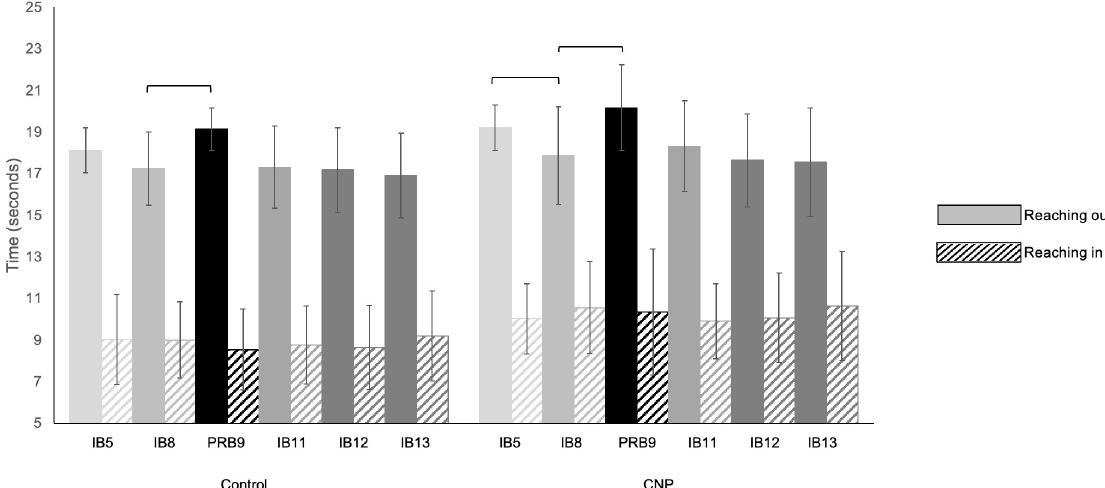
Fig 3. Implicit motor learning. The implicit sequence was introduced in IB5 and practiced continually through IB8. A pseudo-random catch block (PRB9) immediately followed IB8 to assess implicit motor learning. The stability of implicit motor learning was assessed in implicit block (IB11) following disruption from the pseudo-random catch block and following a 30-minute delay (IB13). Reaching outward movements are represented by solid bars, inward reaching movements by striped bars. Error bars represent standard deviations. Brackets indicate a significant within-group difference according to a Sign test, p <